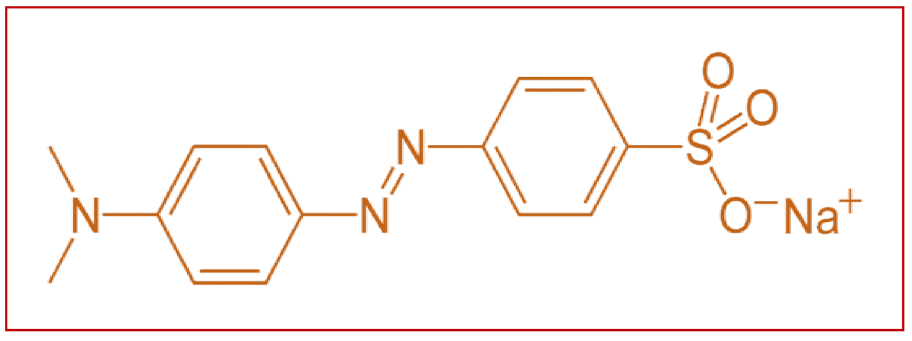
Figure 8. Methyl orange chemical